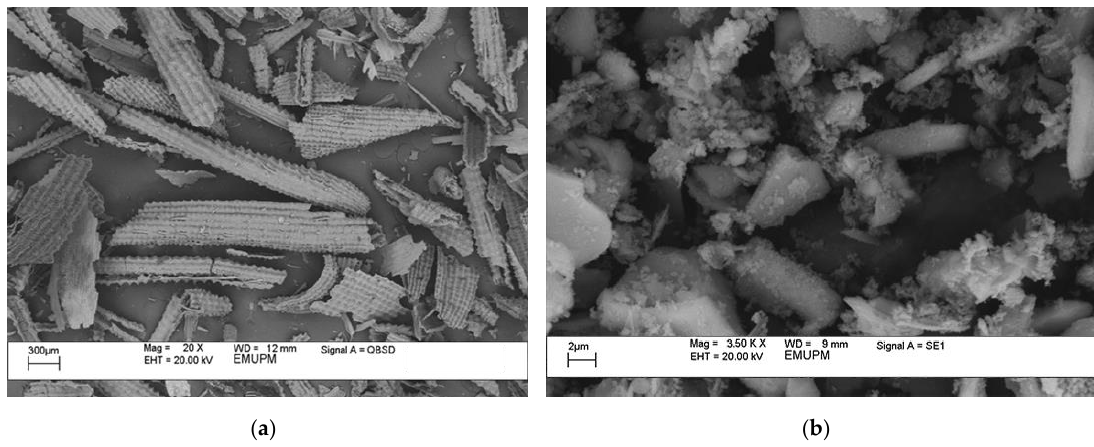
Figure 4. SEM images of Rice Husk Ash (RHA) particles ( a ) before and ( b ) after